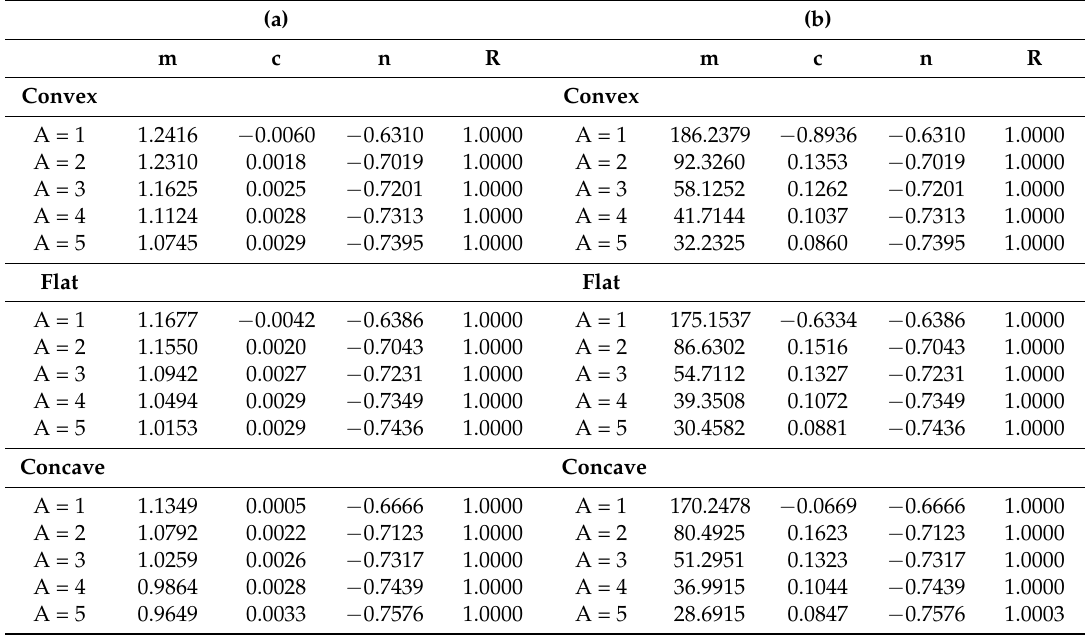
Figure 4. Dimensionless currents calculated for five different channel heights A = 1, 2, 3, 4, and 5 du for: ( a ) bumped ( b ) inlaid, and ( c ) recessed electrode geometries. For each of the three geometries considered, the dimensionless current values decreased as the P é clet number and the channel height increased. Mesh size d = 0.02 du. Channel length L = 10 du. Table 1. Fitting of the dimensionless currents ( a ) and collection percentages ( b ) reported in Figures 4 and 5 respectively. For each of the three considered geometries, the values have been fitted using the function y = m • x n + c . R represents the fitting error.